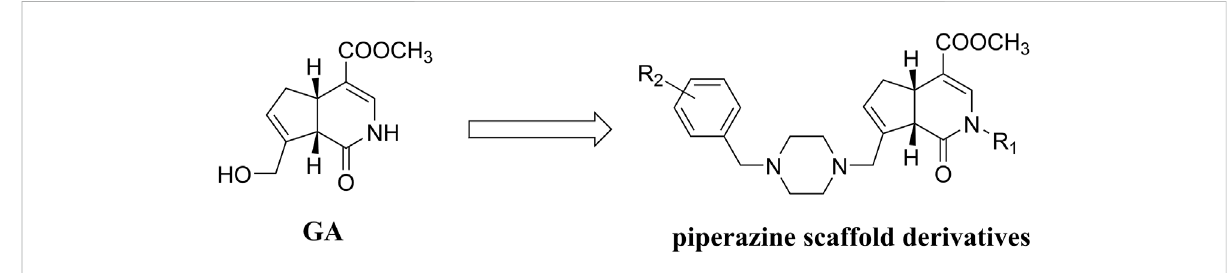
FIGURE 4 Chemical structure of derivatives for GA based on the piperazine scaffold.